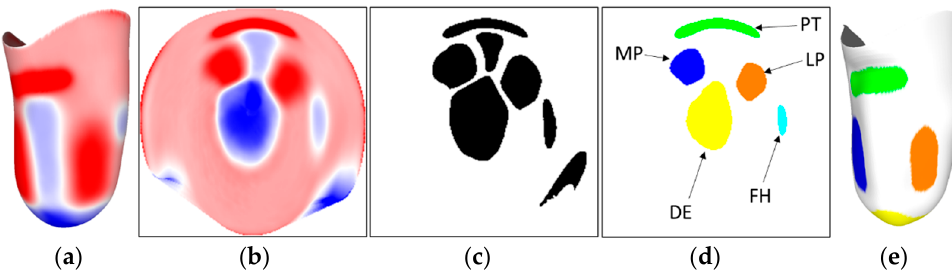
Figure 3. K-means clustering method for identifying and measuring local rectifications. The socket curvature and rectification maps are taken as inputs ( a ) and mapped onto 244 × 244-pixel 2D arrays ( b ). K-means clustering is used to identify regions of pixels representing design features ( c ). These are clustered, and desired features are classified using their shape and location, labelled ( d ), and finally mapped back onto the 3D socket shape ( e ).